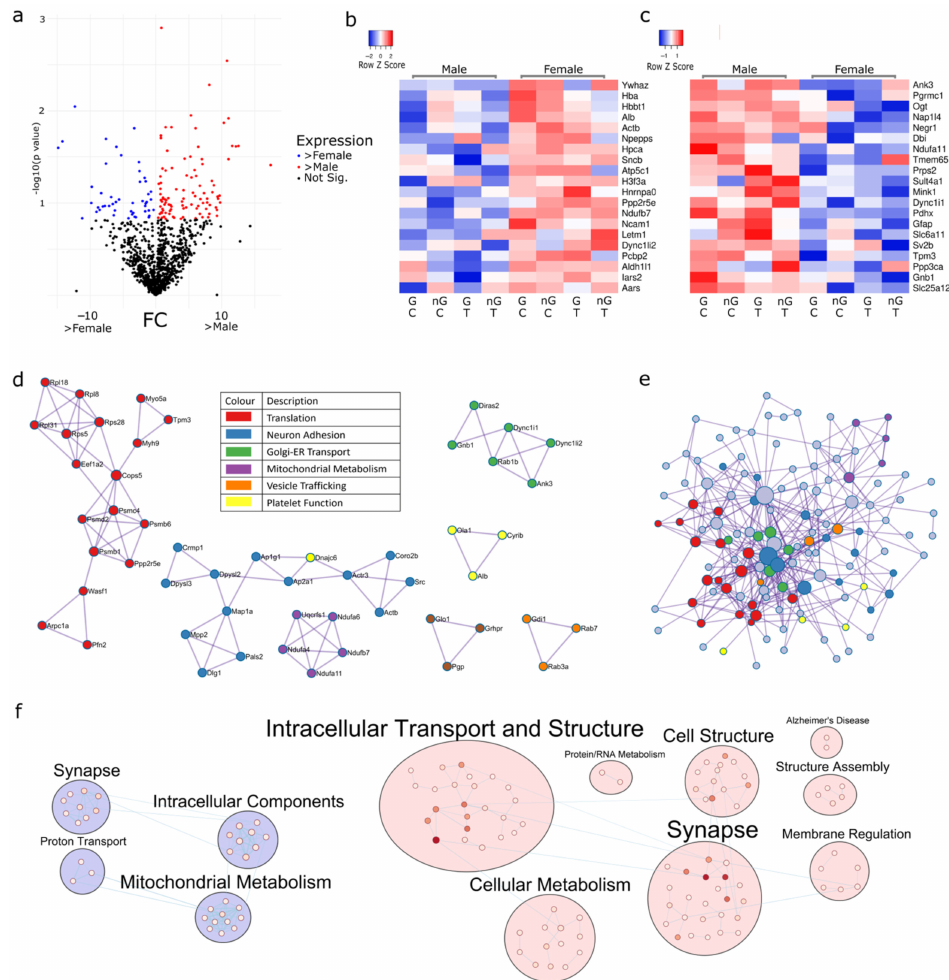
Figure 1. Proteins significantly regulated according to sex. Proteins with sexually dimorphic ex- pression are presented using a volcano plot ( a ); the top 20 upregulated in females ( b ) and males ( c ) are shown in heatmaps. MCODE-driven PPI analysis ( d ) found multiple pathways to be different between males and females, including oxidative phosphorylation (purple, p = 1 × 10 − 11 ), Parkinson’s disease (purple, p = 1.58 × 10 − 11 ), non-alcoholic fatty liver disease (purple, p = 2 × 10 − 11 ), axon guid- ance (blue, p = 1.26 × 10 − 10 ), nervous system development (blue, p = 1.58 × 10 − 10 ) and metabolism of RNA (red, p = 2.5 × 10 − 10 ). PPI full network enrichment analysis ( e ) identified organelle localisation ( p = 5 × 10 − 11 ), establishment of organelle localization ( p = 1.25 × 10 − 9 ) and supramolecular fibre organization ( p = 1.26 × 10 − 9 ). Functionally enriched terms were clustered and mapped into curated bubbles ( f ). In blue, we see the functions which are upregulated in females, and in pink, those upregulated in males. These functions are noted as potentially sexually dimorphic. Darker nodes indicate lower p values. FC: fold chance, G: gonads, nG: no gonads, C: control, T: